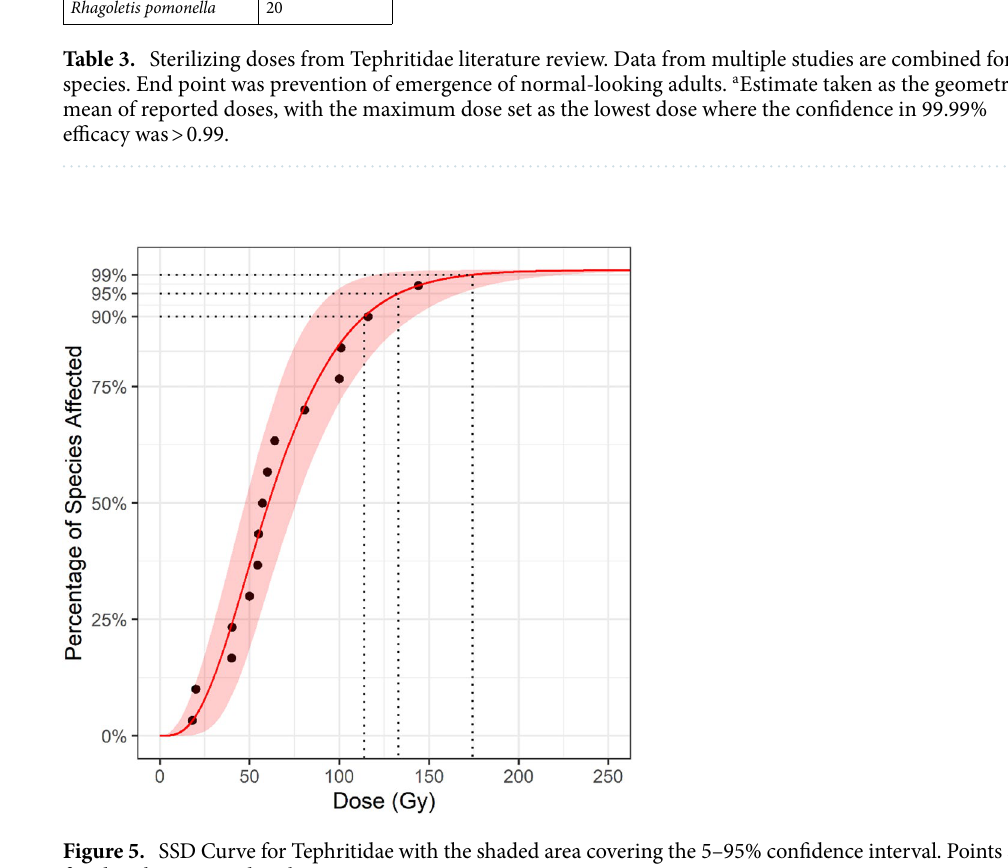
Figure 5. SSD Curve for Tephritidae with the shaded area covering the 5–95% confidence interval. Points are fitted to the gamma